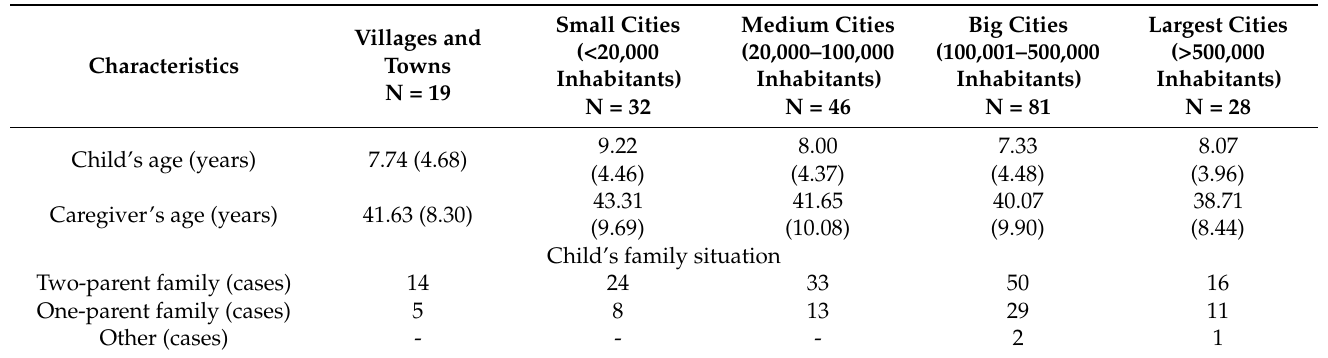
Table 1. Demographic characteristics of participants (N =